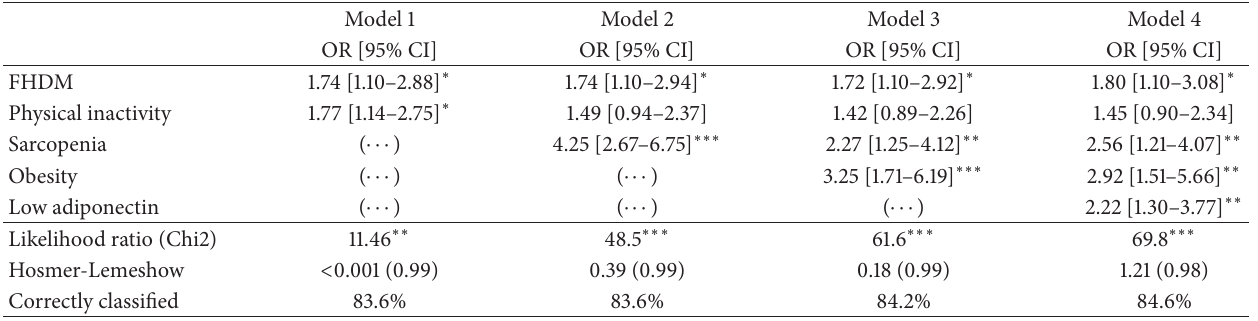
Table 3: Influence of FHDM, physical inactivity, sarcopenia, obesity, and low adiponectin over the risk of insulin resistance ( 𝑛 = 590